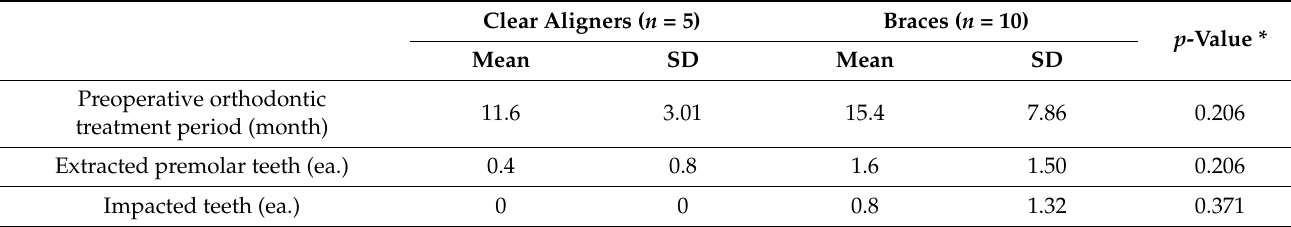
Table 2. Preoperative orthodontic period, number of premolar extraction teeth, and number of impacted teeth between clear aligner group and traditional fixed appliance (e.g., bracket) group.